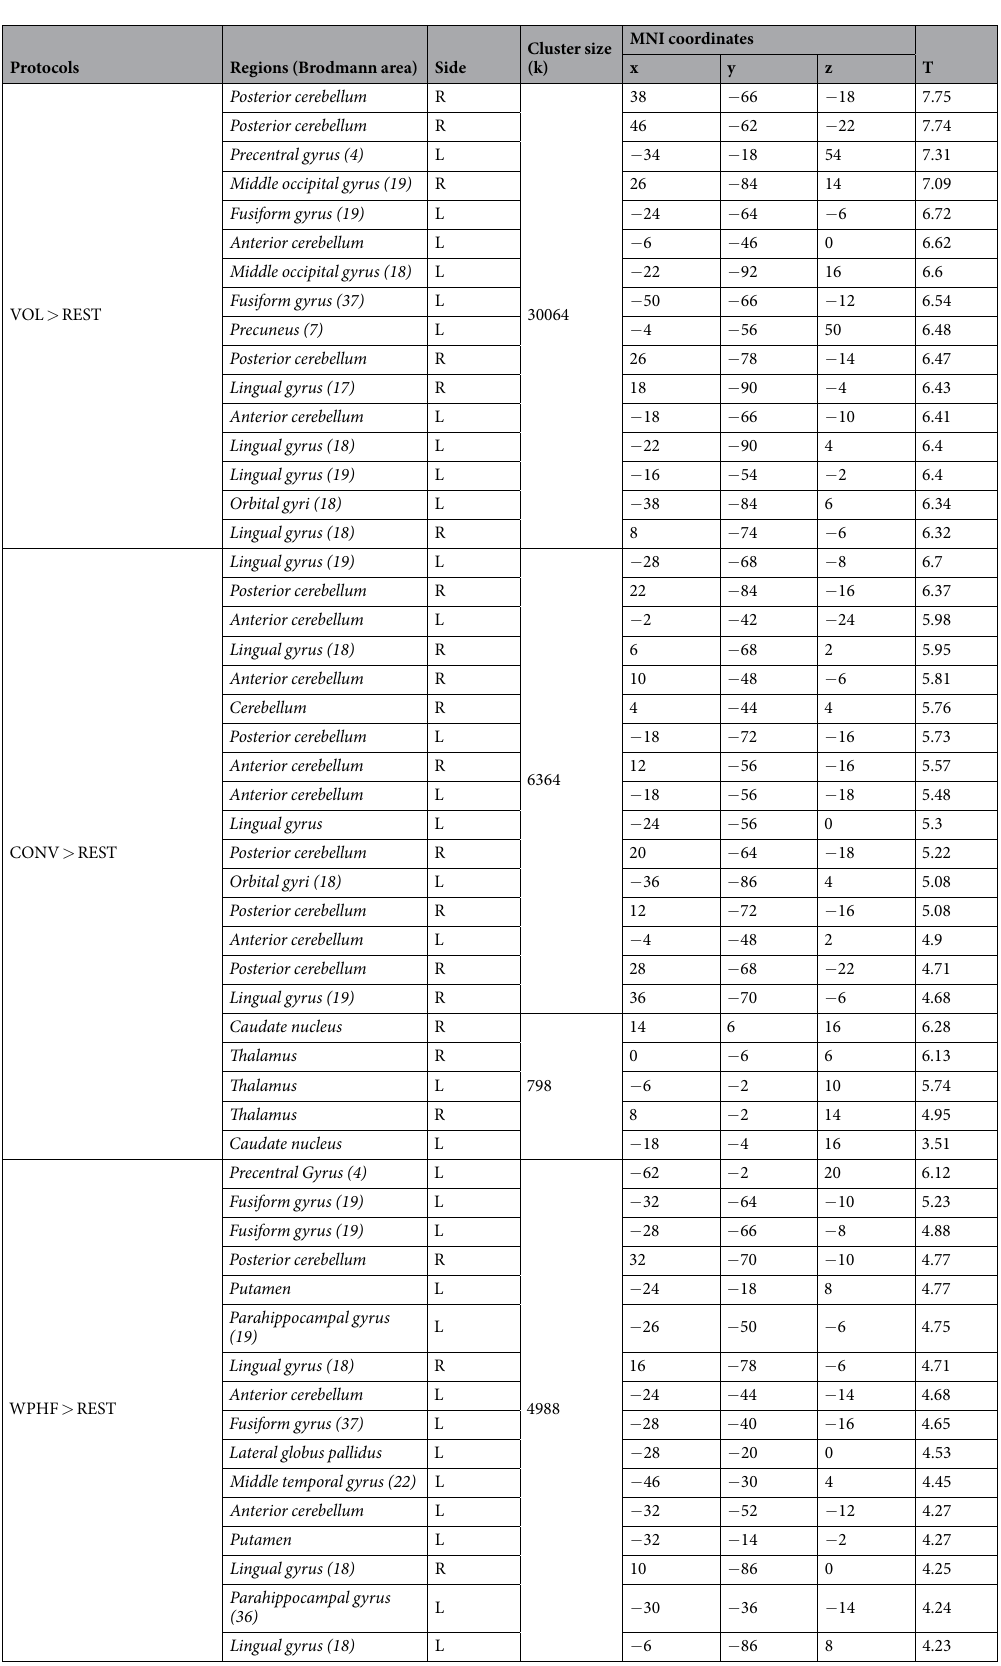
Table 1. Brain regions activated during VOL, CONV and WPHF protocols compared to rest ( p < 0.005; k = 20; FDR corrected at cluster level p <